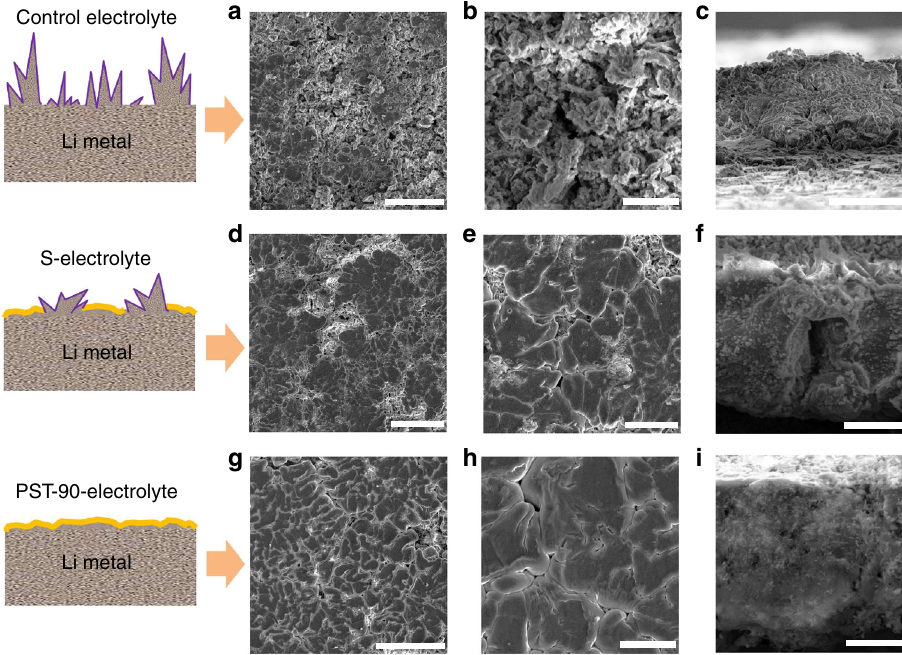
Fig. 2 Morphologies of Li metal deposited onto stainless steel substrates. SEM images of Li metal deposited onto bare stainless steel substrates in the control electrolyte ( a – c ), S-Electrolyte ( d – f ), and PST-90-Electolyte ( g – i ) at a current density of 2 mA cm − 2 and a deposition capacity of 2 mA h cm − 2 . Scale bars in a , b , c : 50, 10, and 10 µ m. Scale bars in d , e , f : 50, 10, and 10 µ m. Scale bars in g , h , i : 50, 10, and 5 µ m. The data shows dense and dendrite - free Li made of highly packed Li is obtained after 10 cycles using